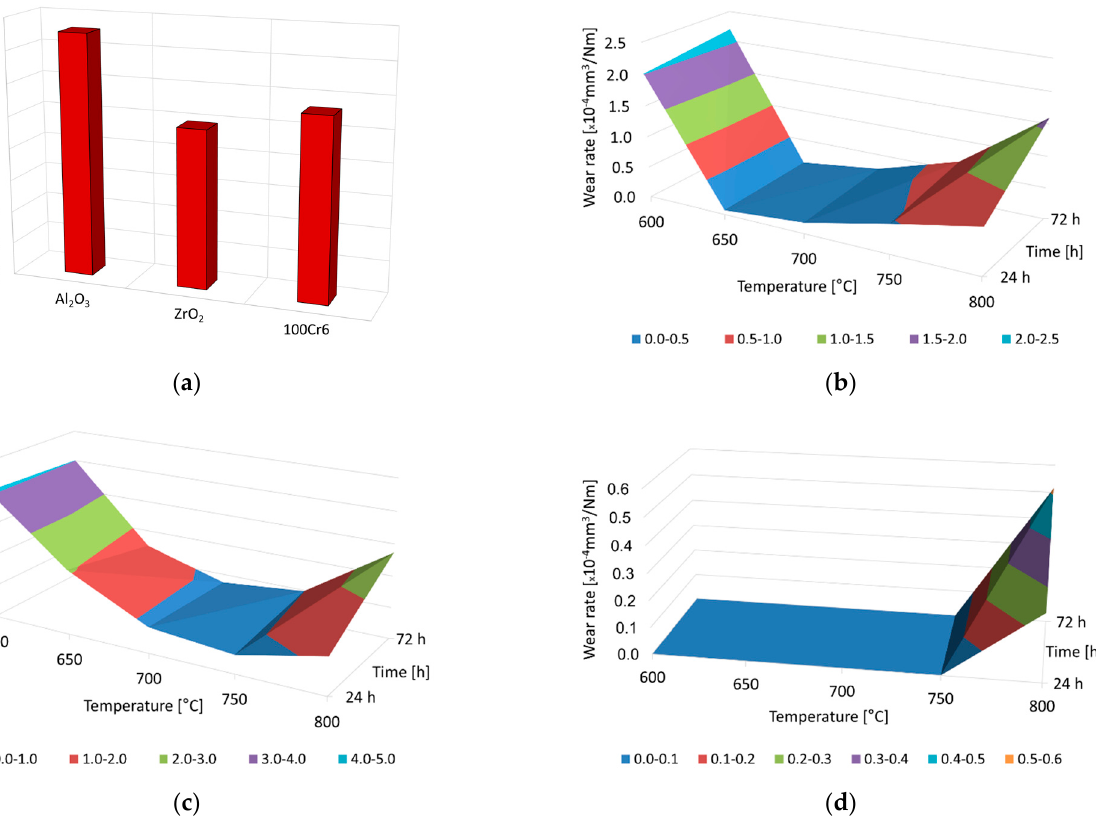
Figure 5. Wear rate for the Ti-6Al-7Nb alloy in the as-received condition ( a ) and after thermal oxidation at 600 °C, 650 °C, 700 °C, 750 °C, and 800 °C for 24 h and 72 h, after tribological tests with Al 2 O 3 ( b ), ZrO 2 ( c ) and 100Cr6 ( d ) balls.